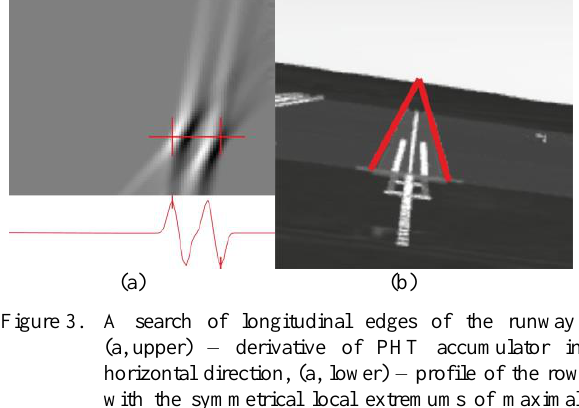
Figure 3. A search of longitudinal edges of the runway: (a, upper) – derivative of PHT accumulator in horizontal direction, (a, lower) – profile of the row with the symmetrical local extremums of maximal amplitude, (b) – the left and the right borders of the runway corresponding to the extremums To determine the position of the top and the bottom runway edges, the assumption is used that the runway image area is brighter than the surrounding background. The edges correspond to the most significant value changes on the projection of intensity values are taken inside the longitudinal line triangle. Reference points are given as the points of intersection of longitudinal edges of the runway with the top and the bottom edges.